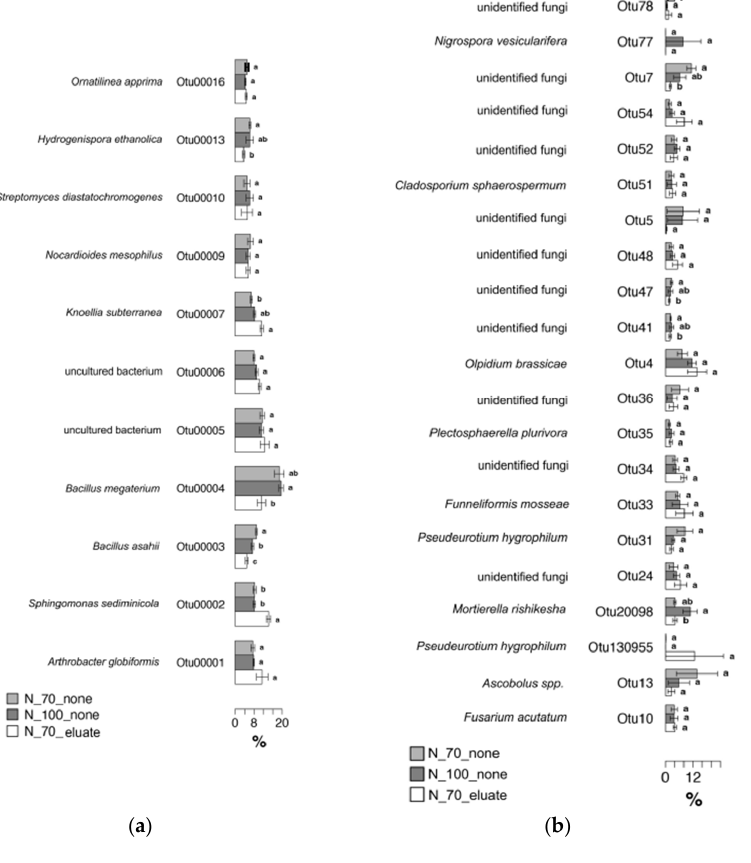
Figure 5. Metastats model output indicating relative abundances of the 11 most abundant bacterial OTUs ( a ) and 21 fungal OTUs ( b ) observed in tomato rhizosphere, comprising 95% of the bacterial diversity found in each treatment. OTUs showing significant differences according to statistical analysis are highlighted with different letters. The assigned genera or species are indicated for each OTU.